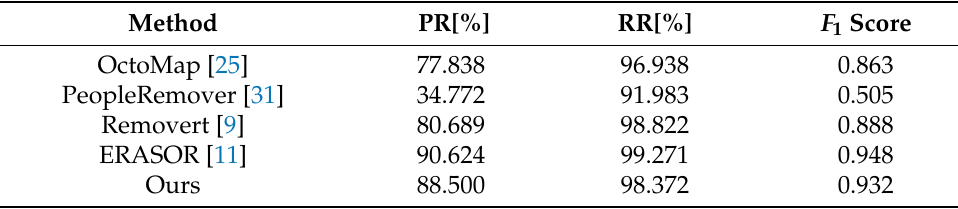
Table 1. Comparison results with state-of-the-art